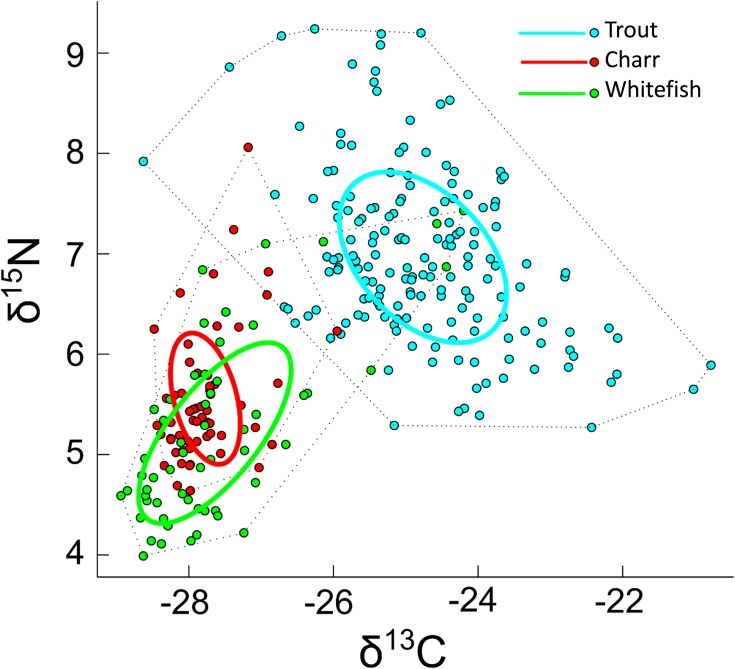
Dietary isotopic niches.Dietary isotopic niches of the three species of fish in Lake Fyresvatn. Dots represent each individual fish in δ15N and δ13C space, ellipses are standard core areas (SEAc) of each species and dotted lines are estimated community metric total areas (TA).